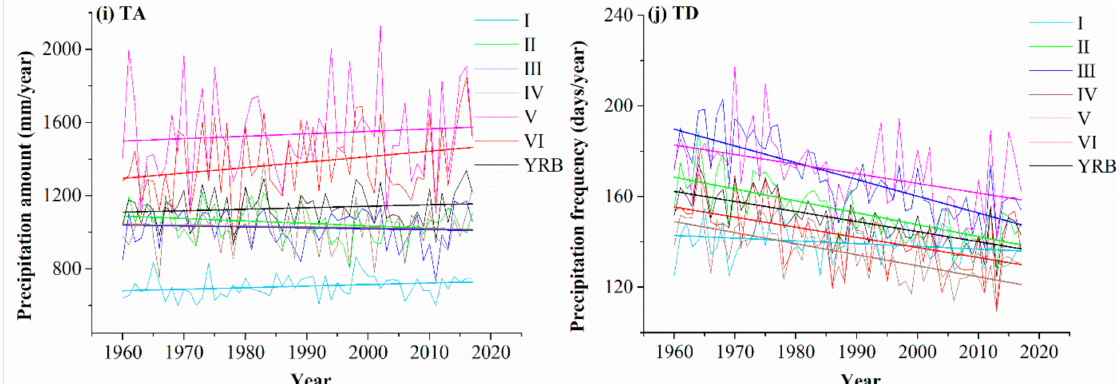
Figure 2. The annual time series of the different grades of precipitation amounts and frequencies ( a – j ) in the whole Yangtze River Basin (YRB) and six subregions (regions I, II, III, IV, V, and VI) from 1960–2017. The bold solid lines represent linear temporal trends. Table 1. The trends of the different grades of precipitation amounts and frequencies over the Yangtze River Basin (YRB) and its six subregions from 1960–2017 (%/10a).